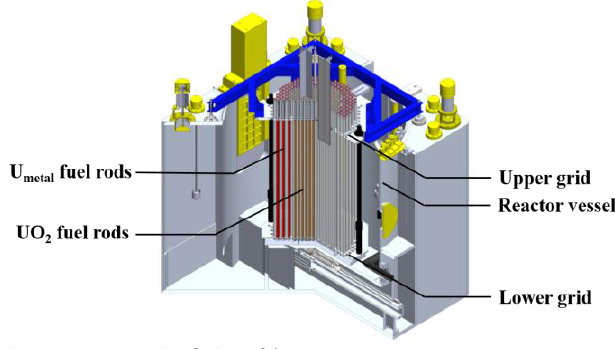
Figure 2. Cross-sectional view of the CROCUS